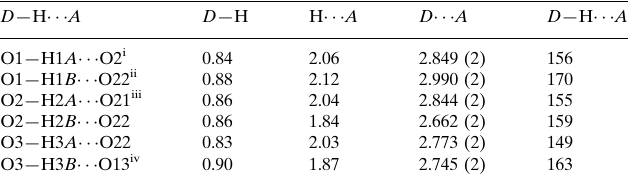
Hydrogen-bond geometry (A˚ , (cid:2)